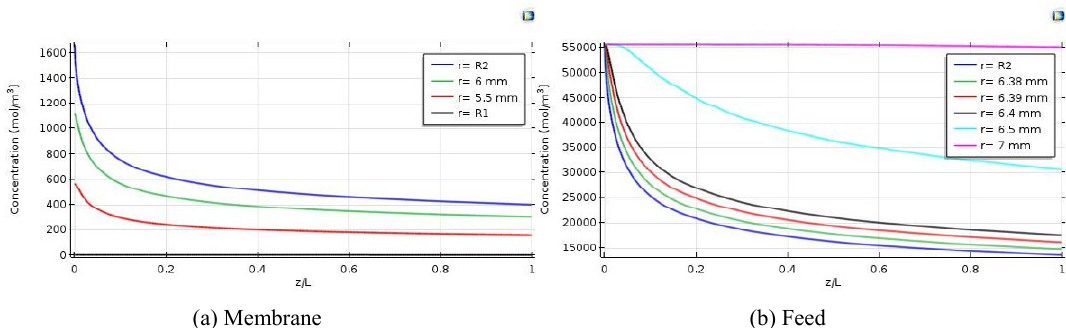
Fig. 9: Water concentration distribution vs. dimensionless length at different radii (60 °C temperature, 1 bar pressure and 3 l/min feed flow rate); (a) Membrane section and (b) Feed section